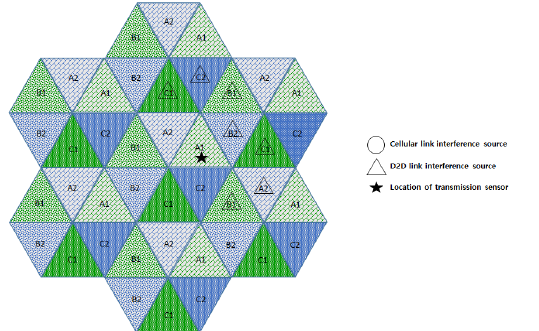
Figure 9. Interference sources to the target D2D link in a semi-static scheme.